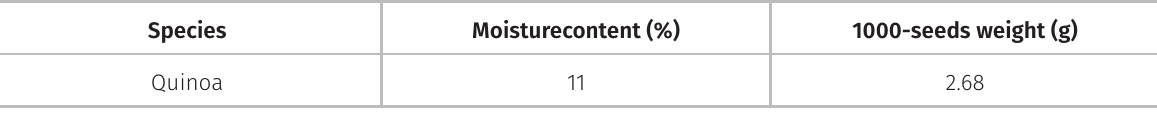
Figure 1. Characterization of external (a) and internal (b) structures of quinoa